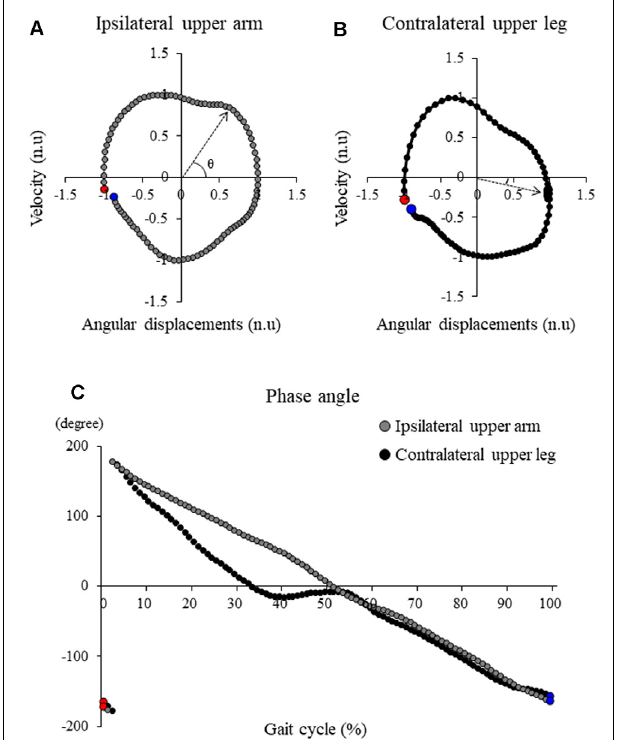
FIGURE 2 | Typical samples of the angle-velocity phase plot in (A) ipsilateral upper arm and (B) contralateral upper leg and (C) the phase angle profile of these segments. Red markers and blue markers represent the first point and the last point during one gait cycle, respectively. Continuous relative phase (CRP) between these segments was calculated by subtracting the specific segment phase angle time series from each other.